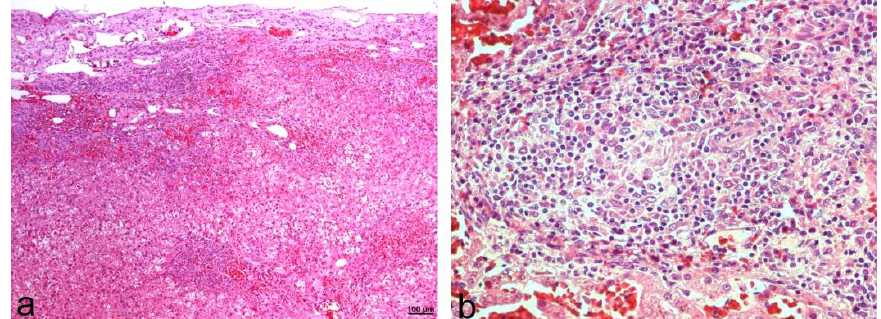
Figure 8. Microscopic findings in dog 3. ( a ) Granulomatous hepatitis, located mainly in the portal and subcapsular areas, with collapsed parenchyma, capsular fibrosis, evident blood vessels, and marked fatty degeneration of hepatocytes. H&E; 50×. ( b ) Granulomatous hepatitis with macro- phages forming a poorly organized central granuloma, mixed with lymphocytes. H&E; 200×.